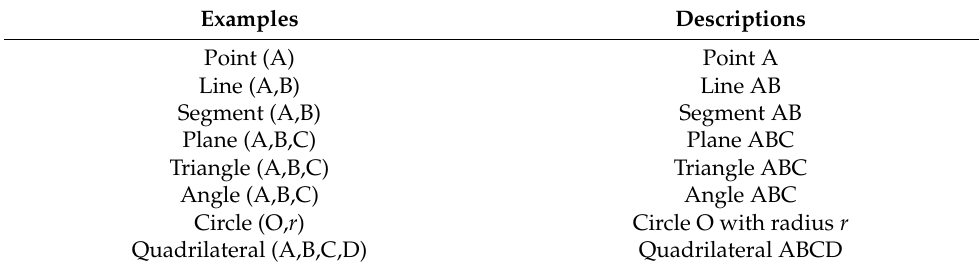
Table 1. Examples of common geometry